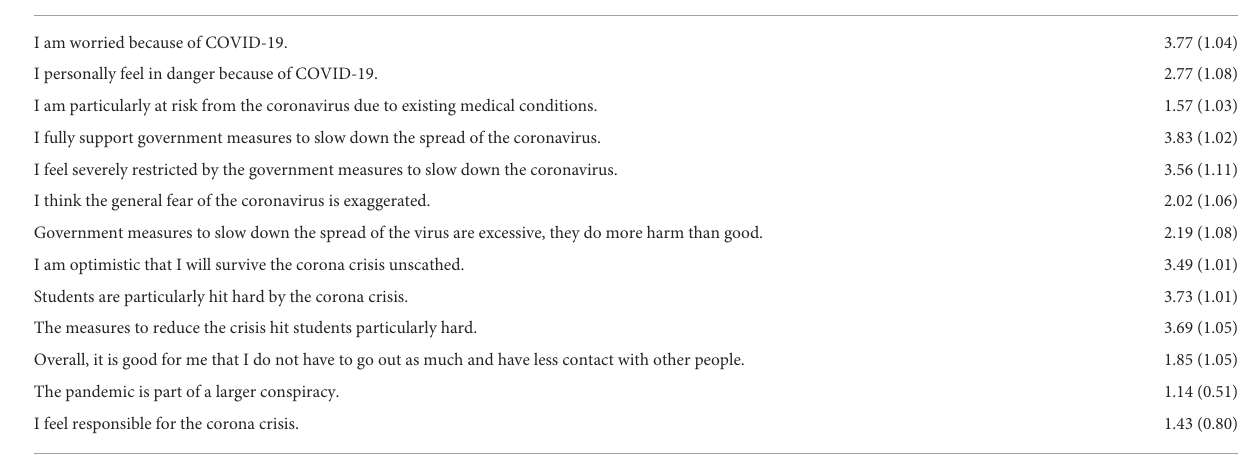
TABLE 2 Attitudes toward the pandemic in university students ( N = 5,639). Item M